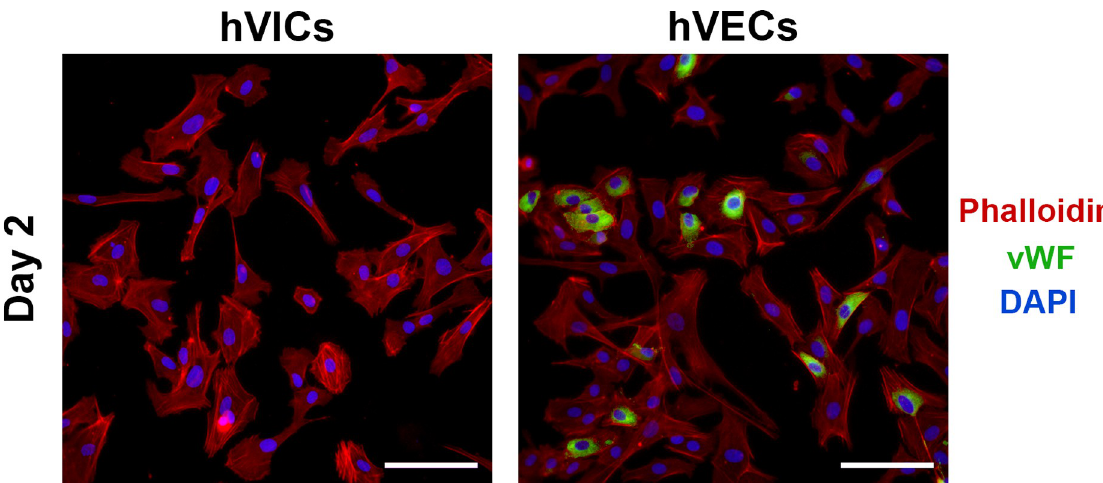
Fig 1. vWF immunostaining. hVICs and hVECs stained for vWF (green), phalloidin (red), and DAPI (blue). Scale bars represent 100 μ m.